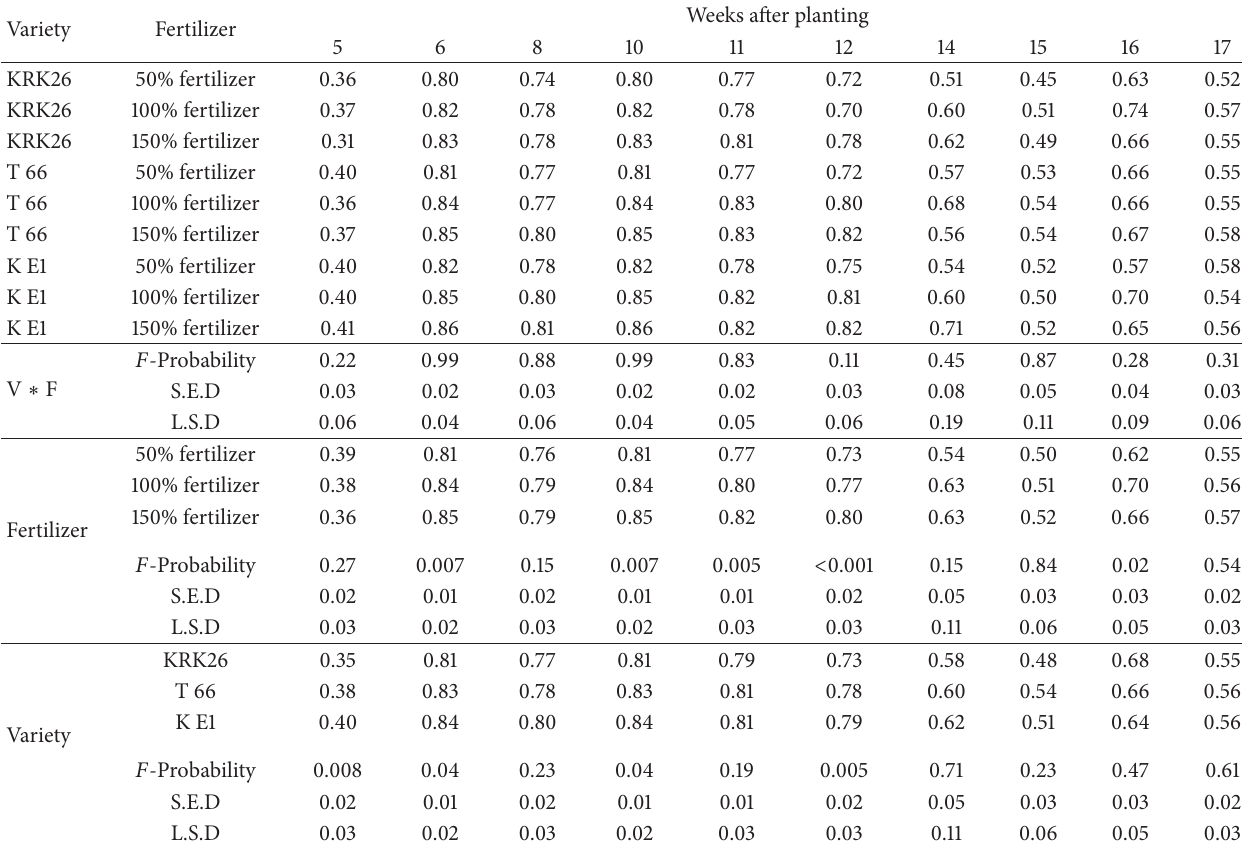
Table 4: The NDVI temporal profiles for the October 15 planted